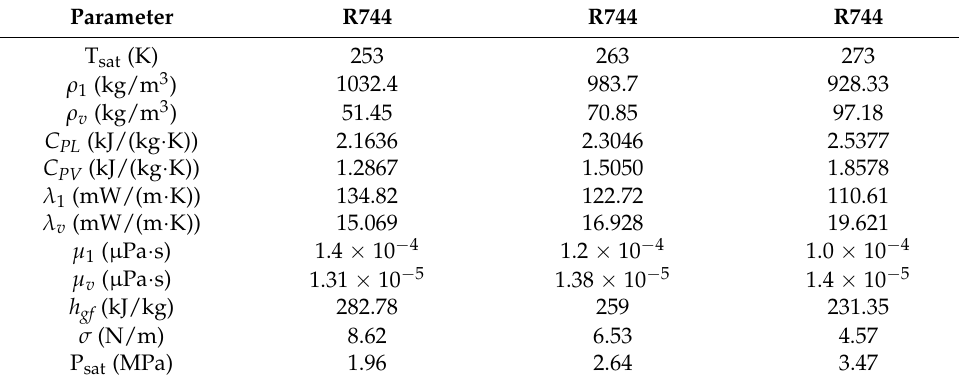
Table 2. Thermophysical parameters of R744.